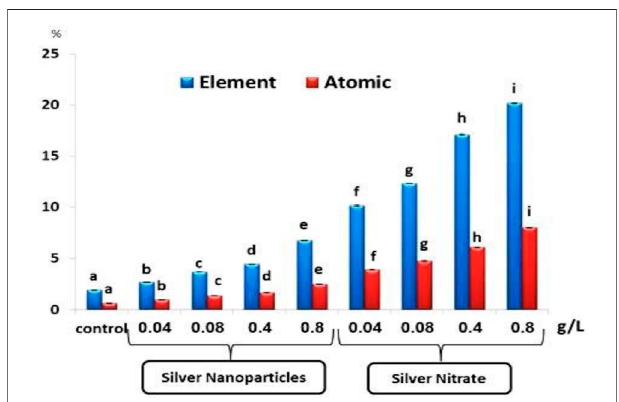
FIGURE 2 | The percentage of silver as element and atomic in the total body of the slugs, ( Lehmannia nyctelia ), after 15 days of exposure. Bars represent the mean ± SE of the control and experimental groups. Different letters indicate signi fi cant differences amongst treatments ( p < 0.05).